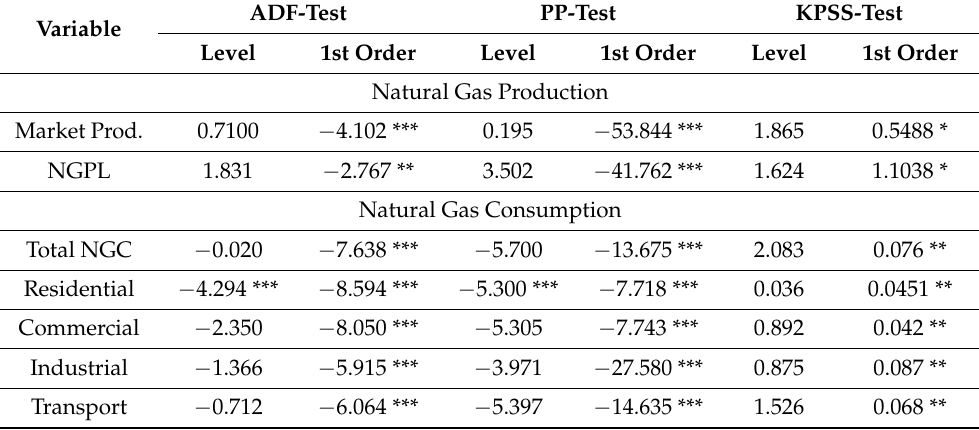
Table 2. Summary of unit root